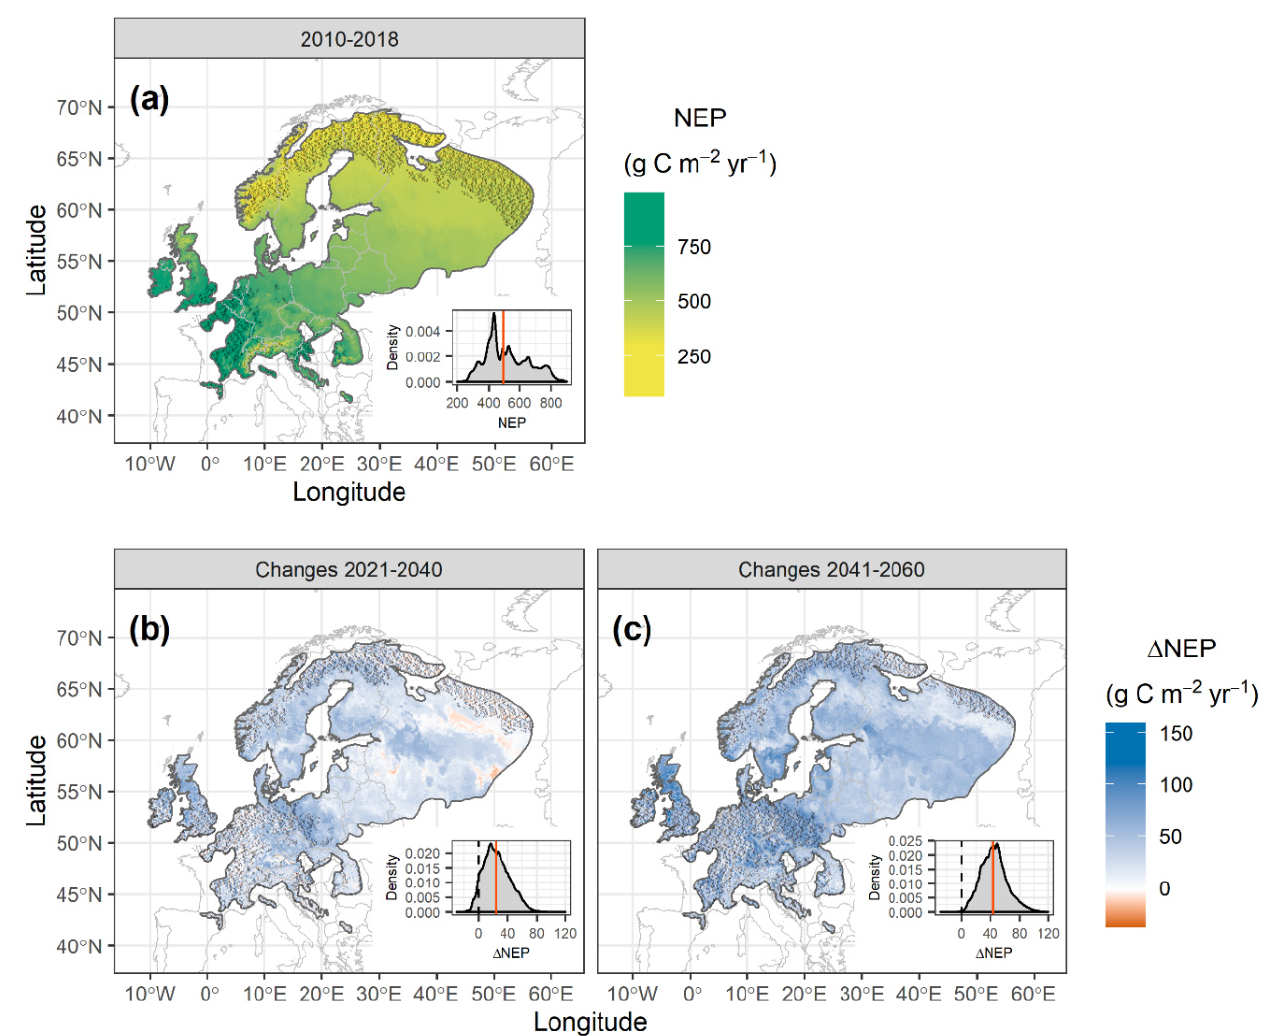
Figure 4. NEP predictions for mature Norway spruce forests based on the climate during 2010–2018 ( a ) and the predicted changes in NEP values during 2021–2040 ( b ) and 2041–2060 ( c ) under the SSP2-4.5 scenario as compared with the NEP values in 2010–2018. The frequency distribution of the values in each map is presented in the corresponding inset with the red vertical lines indicating the medians. The predictions were performed in areas of current Norway spruce forest distribution in Europe. Areas with T a that are beyond the range of the used data are marked with black shadows.